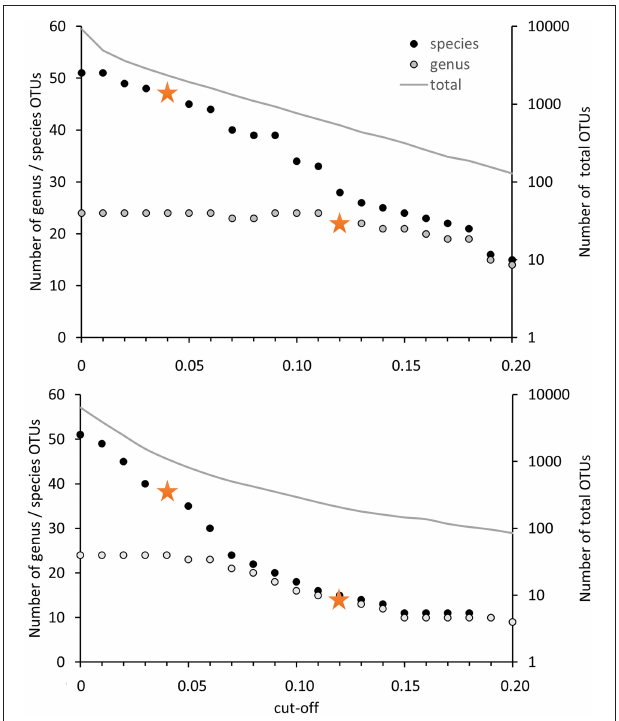
FIGURE 3 | Number of OTUs in dependence on the cut-off value applied for OTU differentiation. The number of OTUs containing type strains of different genera or species are displayed on the left axis, the number of OTUs formed based on all high quality sequences ( = total) is presented on the right axis at logarithmic scale. Clustering was performed with 12502 high quality pmoA sequences (upper panel) or the deduced amino acid sequences (lower panel) available from Genbank. Sequences with at least 400bp sequence length and without accumulation of sequencing errors were included. Distance matrices were calculated in ARB based on 480 aligned nucleotide positions or 160 deduced amino acid positions. OTU clustering was done using Mothur by applying the average neighbor algorithm. Orange stars denote the cut-off values applied in this